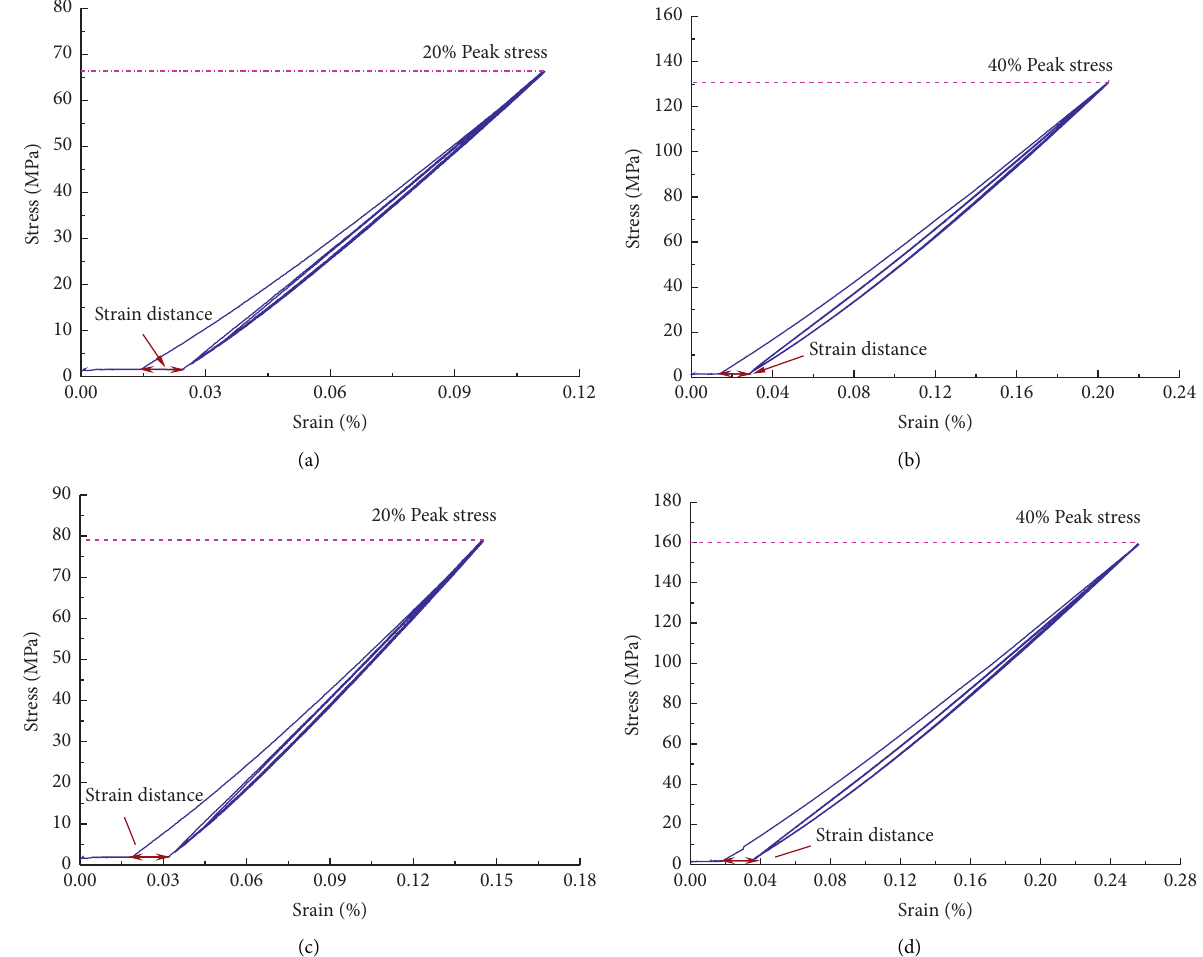
Figure 8: Time-delay characteristic verification test of granite. (a) 20% peak stress under 10 MPa. (b) 40% peak stress under 10MPa. (c) 20% peak stress under 20MPa. (d) 40% peak stress under 20 MPa.